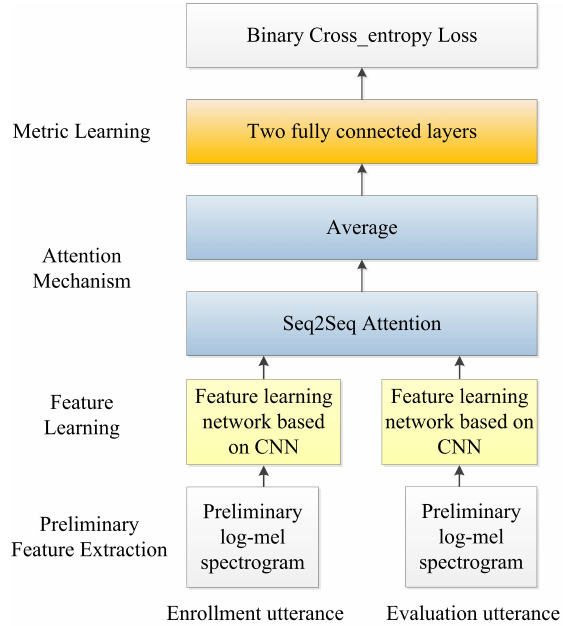
Figure 2. Demonstration of the Sequence to Sequence (Seq2Seq) [7] attention-based text-dependent speaker verification (TDSV)